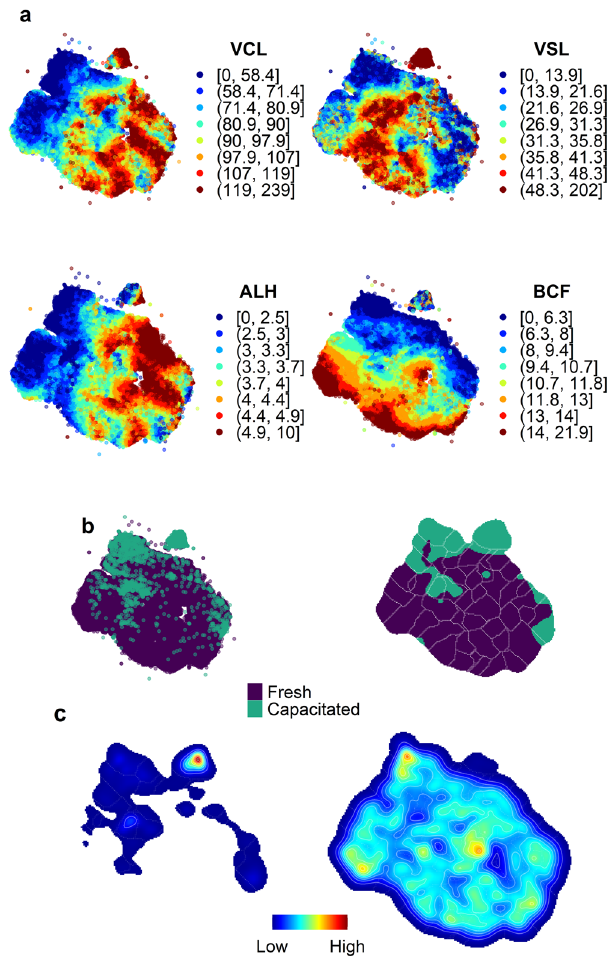
Fig. 5 Sperm motility features of fresh and capacitated sperm. a Quantile map of the motility features used in the t-SNE (VCL curvilinear velocity, VSL straight-line velocity, ALH lateral amplitude of the head displacement, and BCF beat-cross frequency). Colours represent an interval of values (eight percentiles, from 0 – 12.5 to 87.5 – 100) of each variable amended for a gradient visualisation. b Location of fresh sperm (purple) and capacitated sperm (green). Sperm labelled as capacitated were kept in a medium that elicits in vitro capacitation (containing albumin, bicarbonate and calcium, amongst others). The left panel is a pointwise representation of capacitated and fresh sperm. The right panel depicts a cell-wise hard clustering in a 200 × 200 grid. Cells were assigned "capacitated" or "fresh" depending on the density of points in each category (i.e., if a cell had a higher proportion of fresh sperm, it was labelled as fresh, and capacitated otherwise). c Heatmap of the landscape distribution of capacitated (left panel) and fresh sperm (right